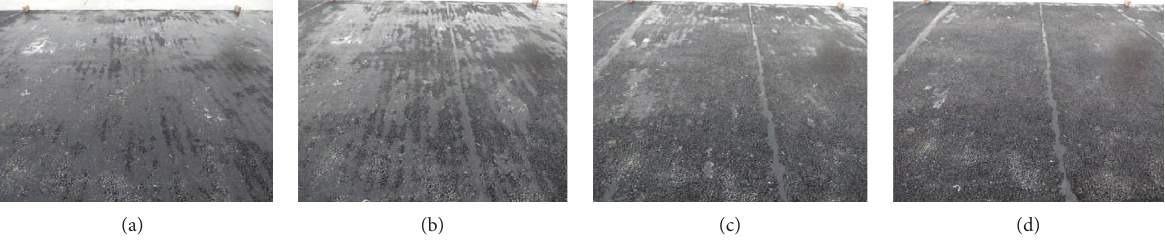
Figure 4: Melting ice on the 1# airport asphalt pavement. (a) 90 minutes. (b) 110 minutes. (c) 130 minutes. (d) 150 minutes.